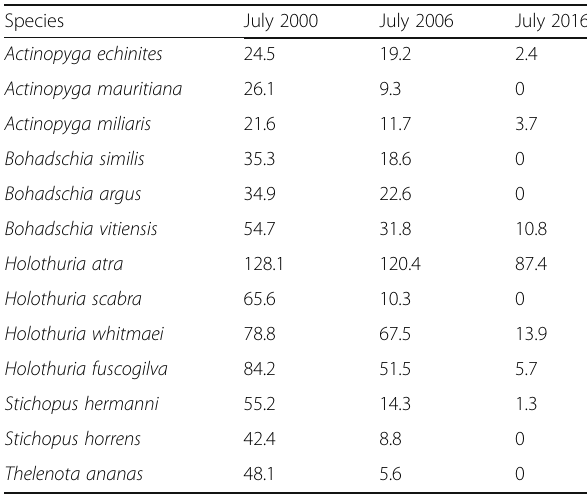
Table 2 Temporal variation in species density of sea cucumber populations (no./100m 2 ) at the surveyed site Species